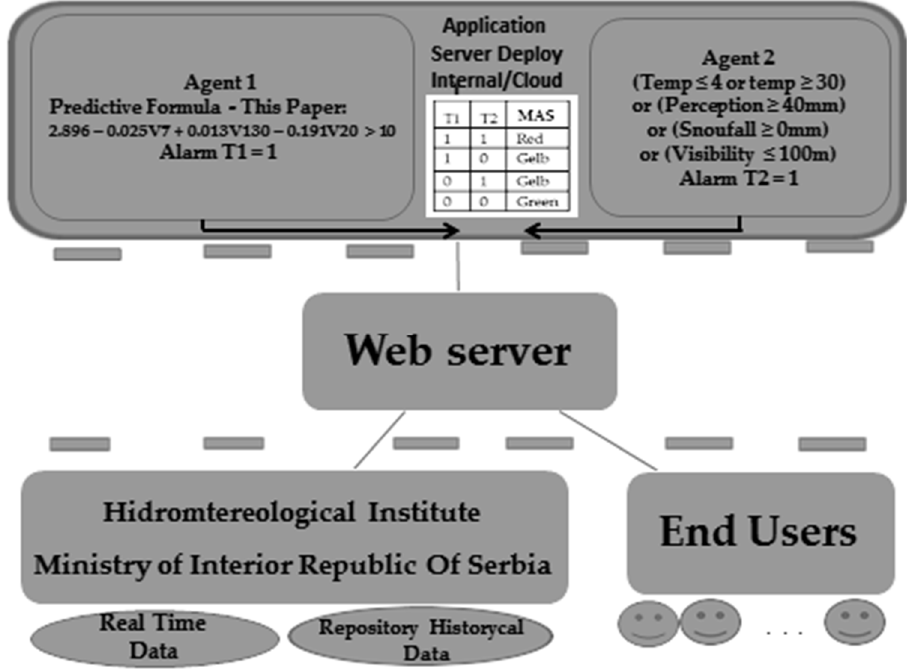
Figure 3. EIT two-agent system for generating a warning of the possibility of traffic accidents.